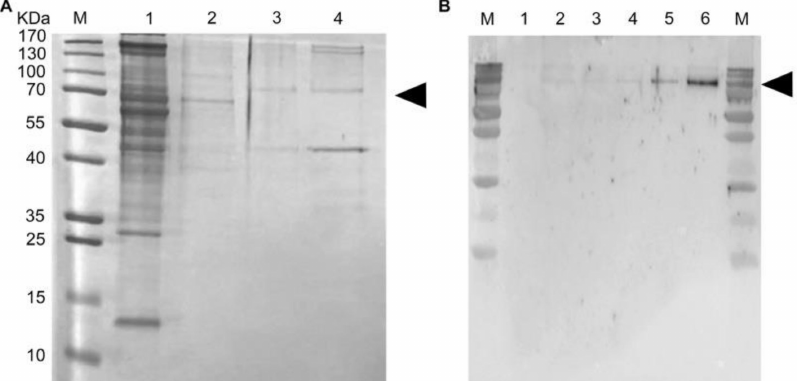
Figure 5. Purification and confirmation of recombinant S protein of SARS-CoV-2 expressed in Drosophila Schneider’s line 2 (S2) cells. ( A ) Purification of recombinant S under different conditions. M: marker, 1: 30 mM imidazole, 2: 60 mM imidazole, 3: 80 mM imidazole, 4: 250 mM imidazole.